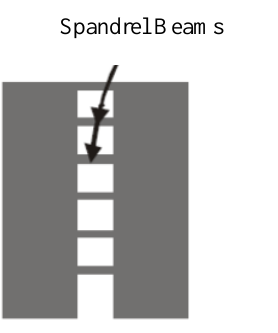
Fig. 1. Spandrel beams in coupled shear